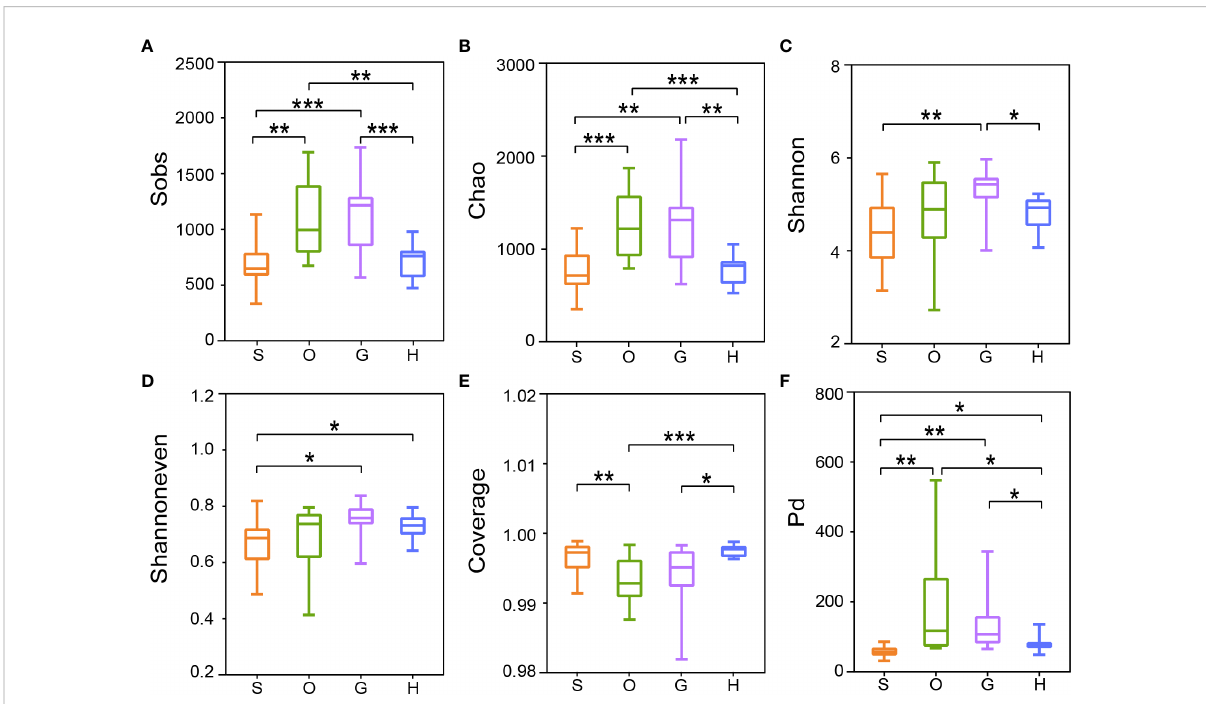
FIGURE 1 Alpha diversity of bacterial communities in four body sites of tunas. The statistical signi fi cance of six alpha diversity indices of (A) Sobs index, (B) Chao index, (C) Shannon index, (D) Shannoneven index, (E) Coverage index, and (F) Pd index were calculated by the Welch ’ s t-test (* p ≤ 0.05; ** p ≤ 0.01; *** p ≤ 0.001). S, skin; O, oral; G, gill; H: